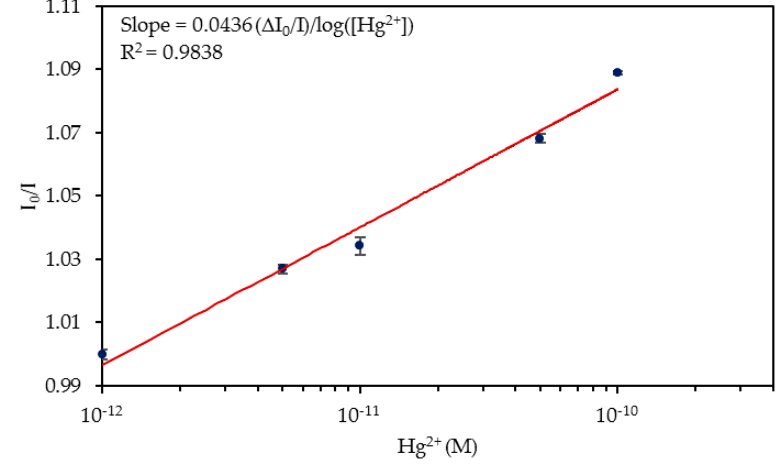
Figure 9. I 0 /I ratio for the different Hg 2+ concentrations in tap water. The horizontal axis is shown in logarithmic scale.